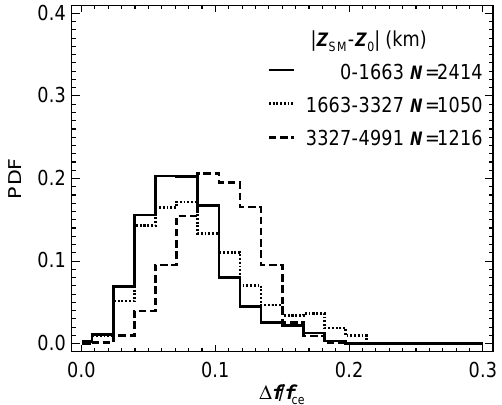
Fig. 8. Histograms of the probability density function of the nor- malized frequency bandwidth estimated for three intervals of the distance from the central position of the chorus source region mea- sured along the Z S M coordinate. Histograms plotted by solid and dotted lines are calculated using data observed closer to the cen- tral position, dashed line means observations closer to the outer boundaries of the source region. The numbers N of individual wave packets falling into the three intervals are, respectively, given on the right-hand